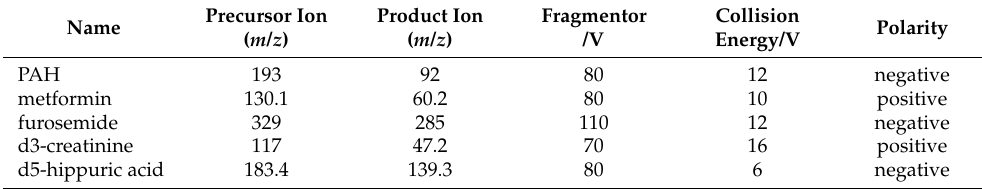
Table 1. Mass spectrometric parameters of PAH, metformin, furosemide and internal